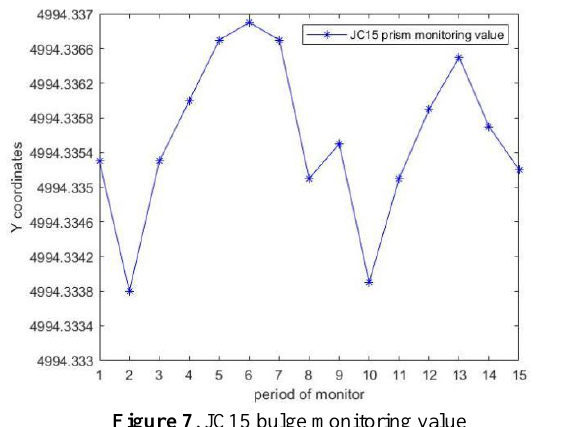
Figure 7 . JC15 bulge monitoring value